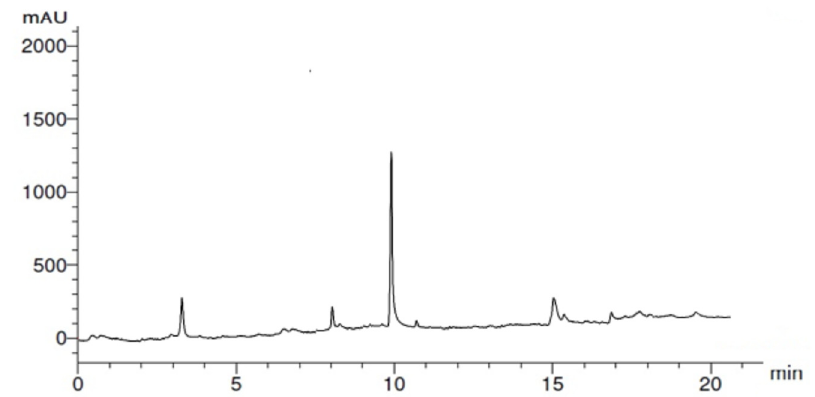
Molecules 2023 , 28 , x FOR PEER REVIEW Figure 1. HPLC chromatogram of flavonoids from GB leaves . Figure 1. HPLC chromatogram of flavonoids from GB leaves.